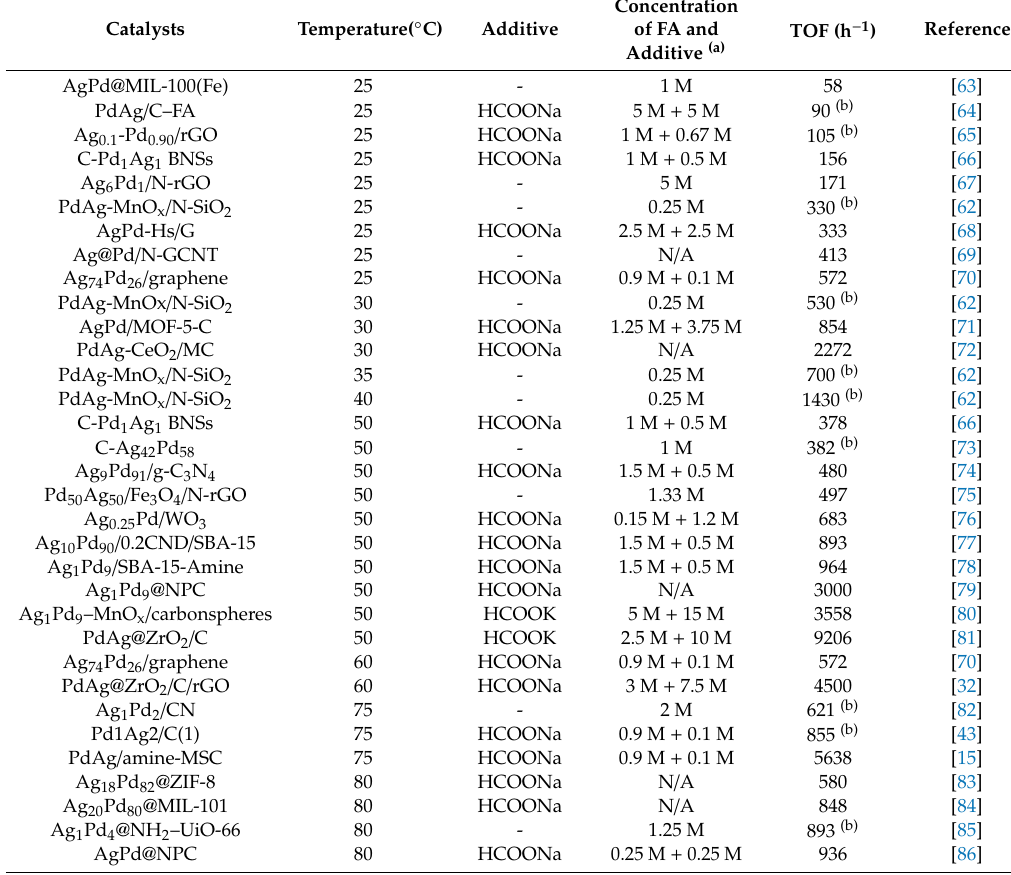
Table 1. PdAg heterogeneous catalytic systems for the dehydrogenation of